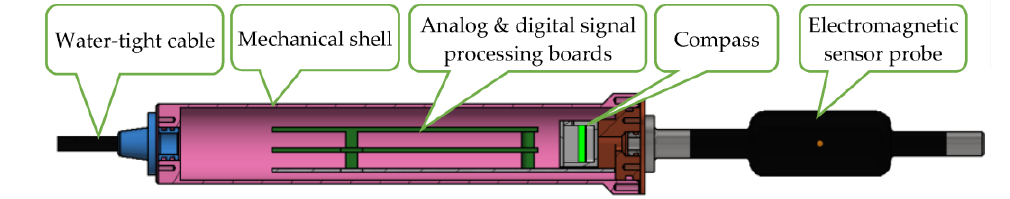
Figure 8. Electromagnetic current meter shape.